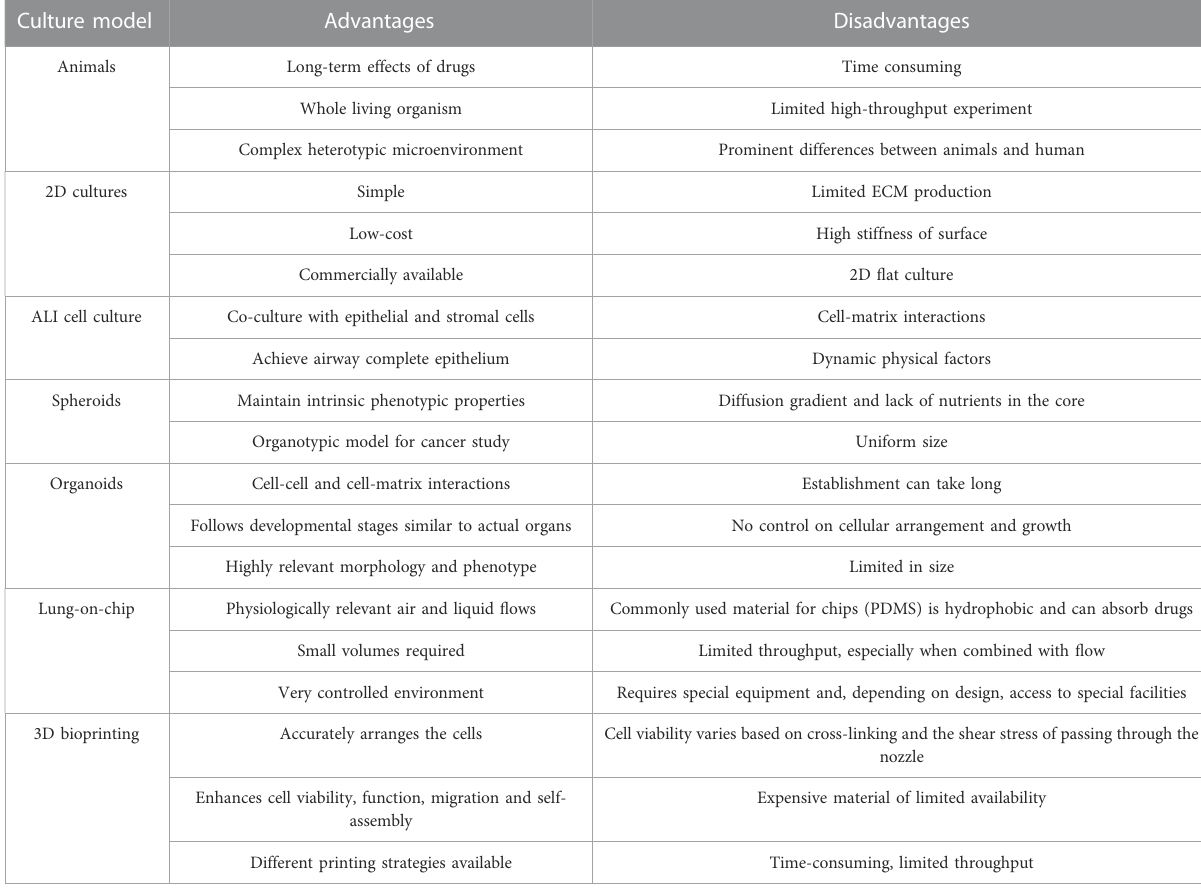
TABLE 1 Summary of the different in vitro models with advantages and disadvantages. Culture